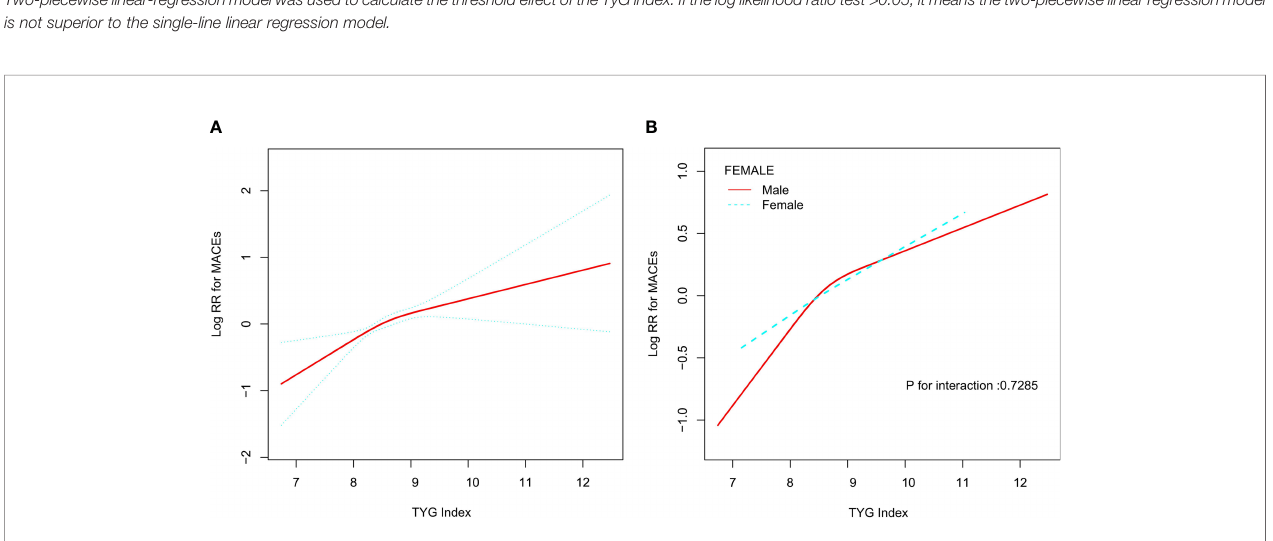
FIGURE 1 | Relationship between Tyg index and MACEs. (A) Relationship between Tyg index and MACEs in all patients. The red line is the trend line and the blue line is the 95% con fi dence interval. (B) Relationship between Tyg index and MACEs grouped by sex. Male: red line; Female: blue